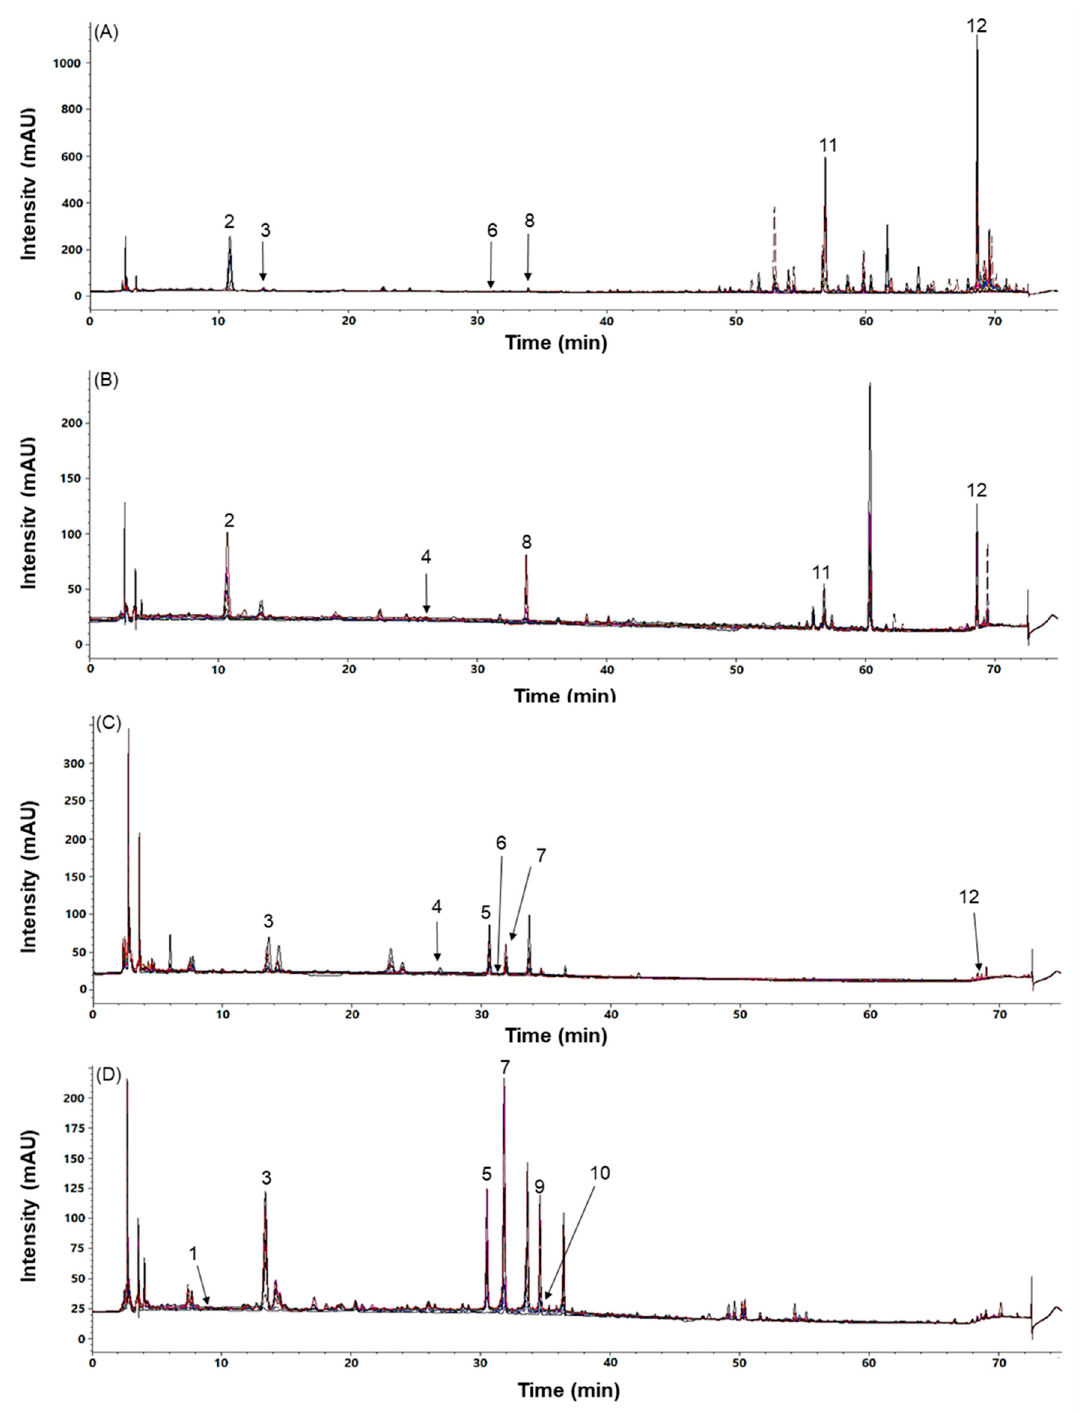
Figure 2. Overlapped chromatograms of the representative samples of the root barks ( A ), the twigs ( B ), the fruits ( C ), and the leaves ( D ) of the Morus samples at the detection wavelength of 265 nm; 1, skimmin; 2, mulberroside A; 3, chlorogenic acid; 4, 4-hydroxycinnamic acid; 5, rutin; 6, taxifolin; 7, isoquercitrin; 8, oxyresveratrol; 9, astragalin; 10, quercitrin; 11, kuwanon G; 12, morusin.